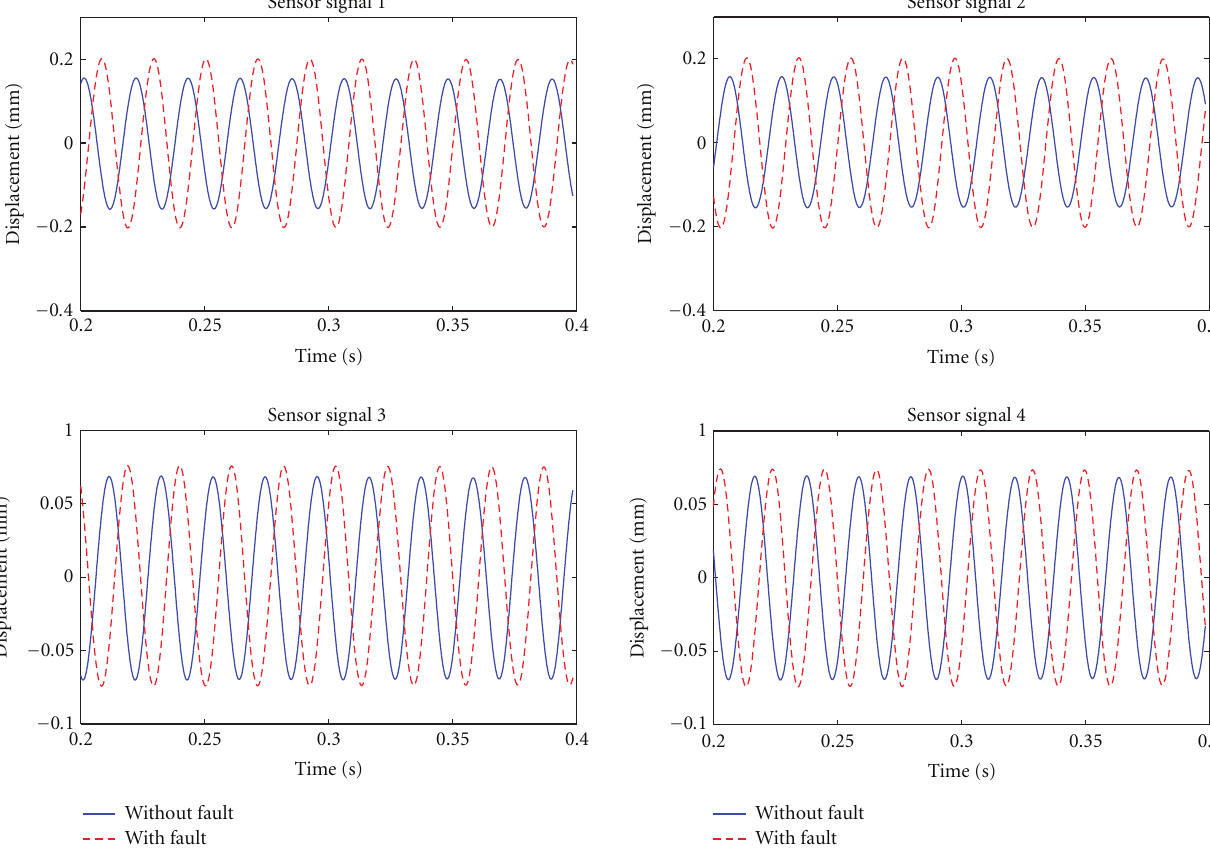
Figure 9: Measurements in steady states at rotary frequency of 47